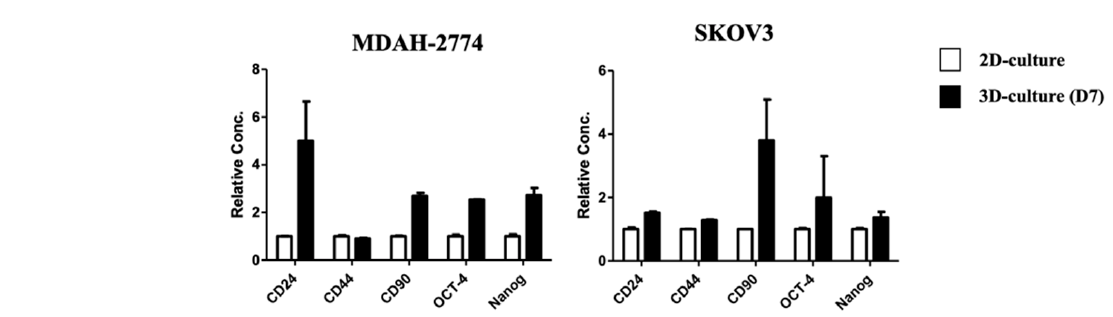
Figure 3. Spheroids derived from cancer cell lines cultured using the ACD 3D culture system exhibit cancer stem cell characteristics. Cells grown in 2D culture cells and spheroids grown in 3D culture were collected on Day 7 for mRNA extraction. mRNA levels of the stemness markers CD24 , CD44 , CD90 , Oct-4 , and Nanog were examined in parent and spheroid cells using Real-time PCR. The white bars show the levels measured in cells from 2D culture, and the black bars show the level measured in spheroids grown in 3D culture. All gene expression levels were normalized against the